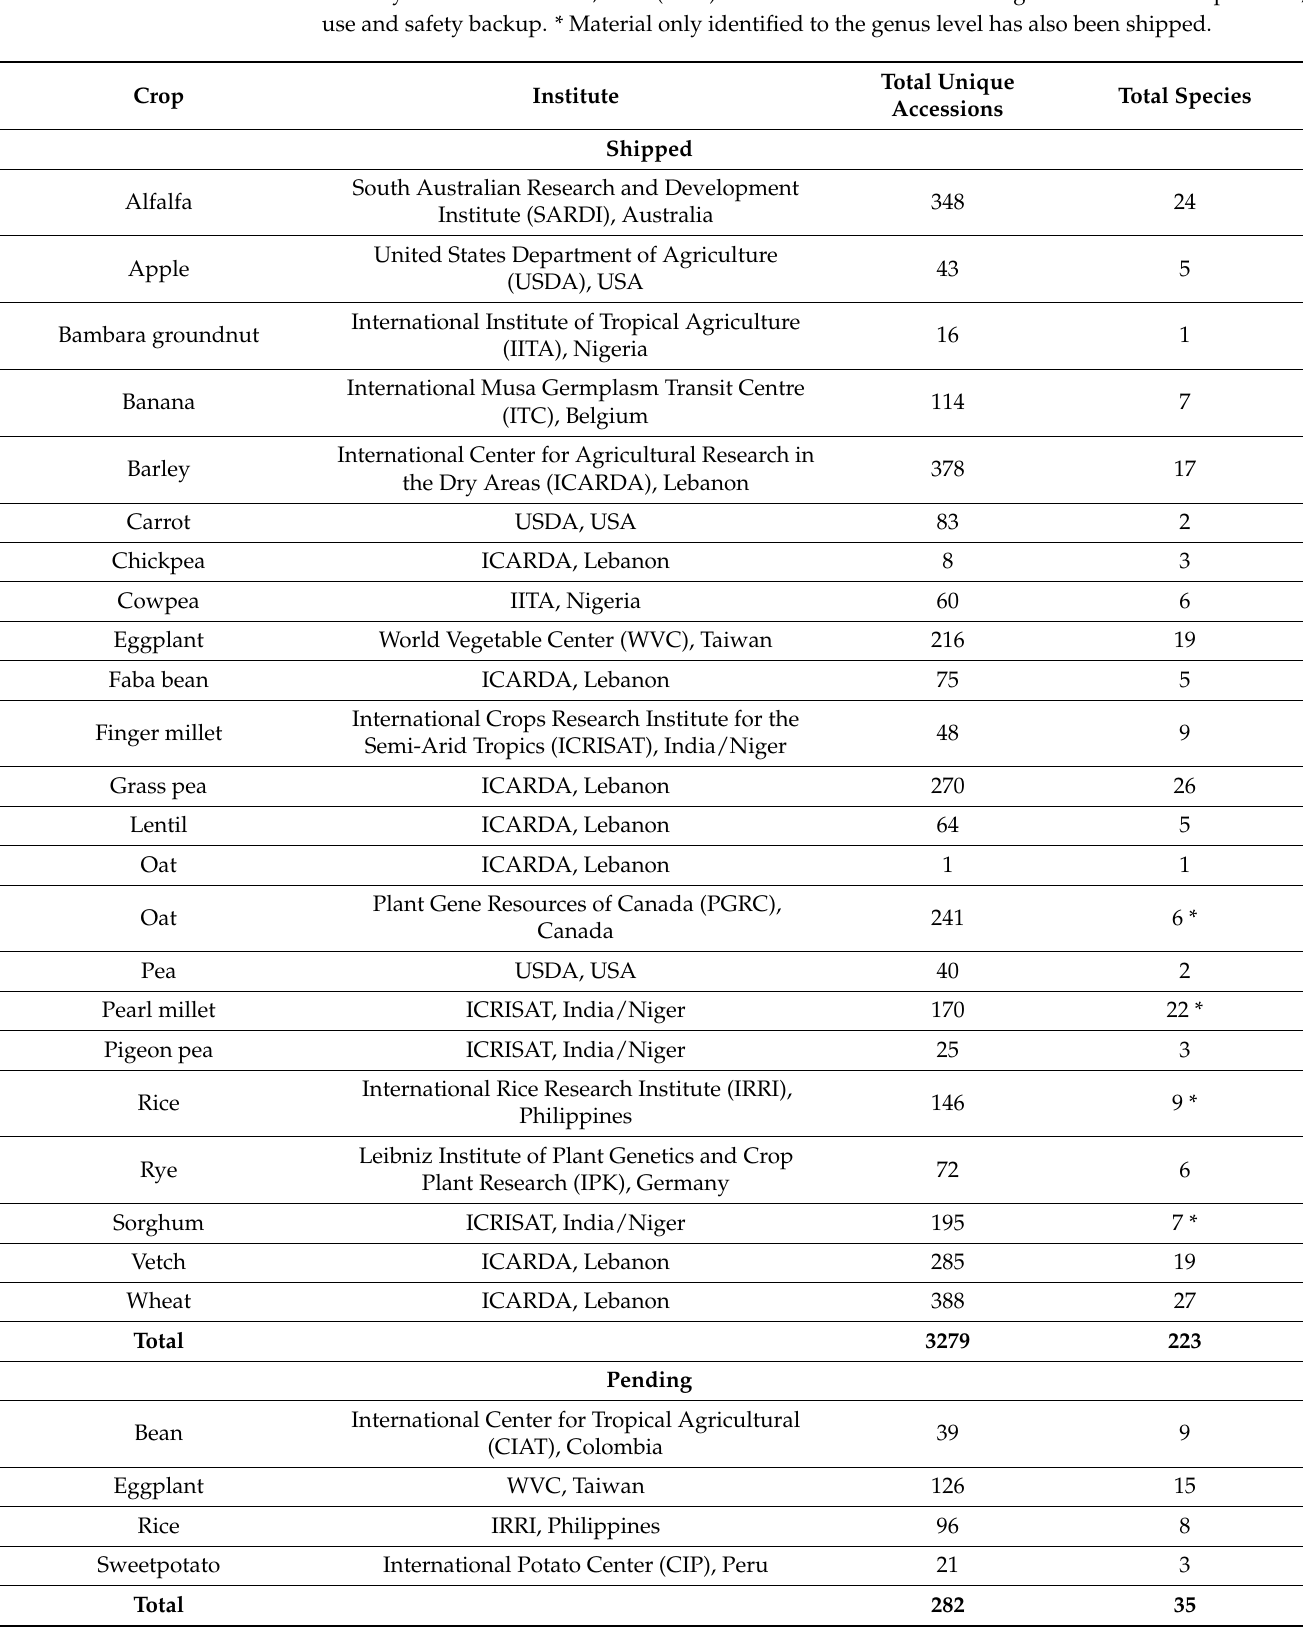
Table 2. Shipments of Adapting Agriculture to Climate Change Project (CWR Project) samples from The Royal Botanic Gardens, Kew (Kew) to national and international genebanks for multiplication, use and safety backup. * Material only identified to the genus level has also been